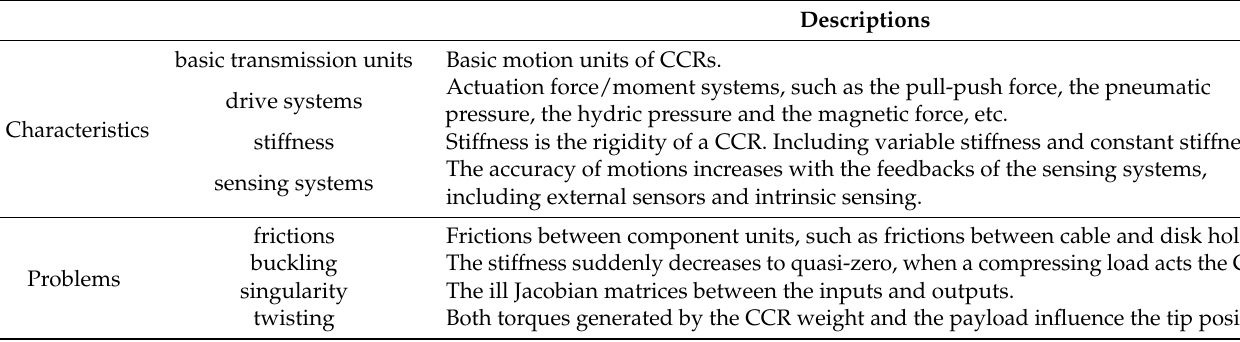
Figure 3. The numbers of publications about different CCRs from the literature review.